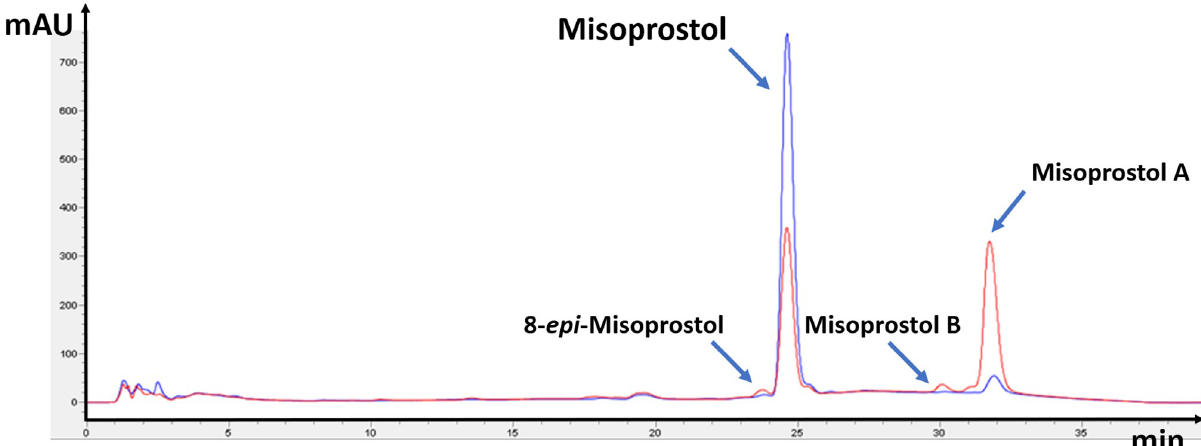
Fig 3. HPLC analysis of misoprostol tablets stored in damaged blisters at 40 ˚C and 75% RH for six months (red line). KONTRAC 200 tablets of Fourrts (India), batch E0571 (see Table 1) were used for this experiment. Tablets of the same batch stored in intact blisters at 25 ˚C and 60% RH for six months are shown as comparison (blue line). HPLC analysis for related substances was carried out according to Kahsay et al. [35].